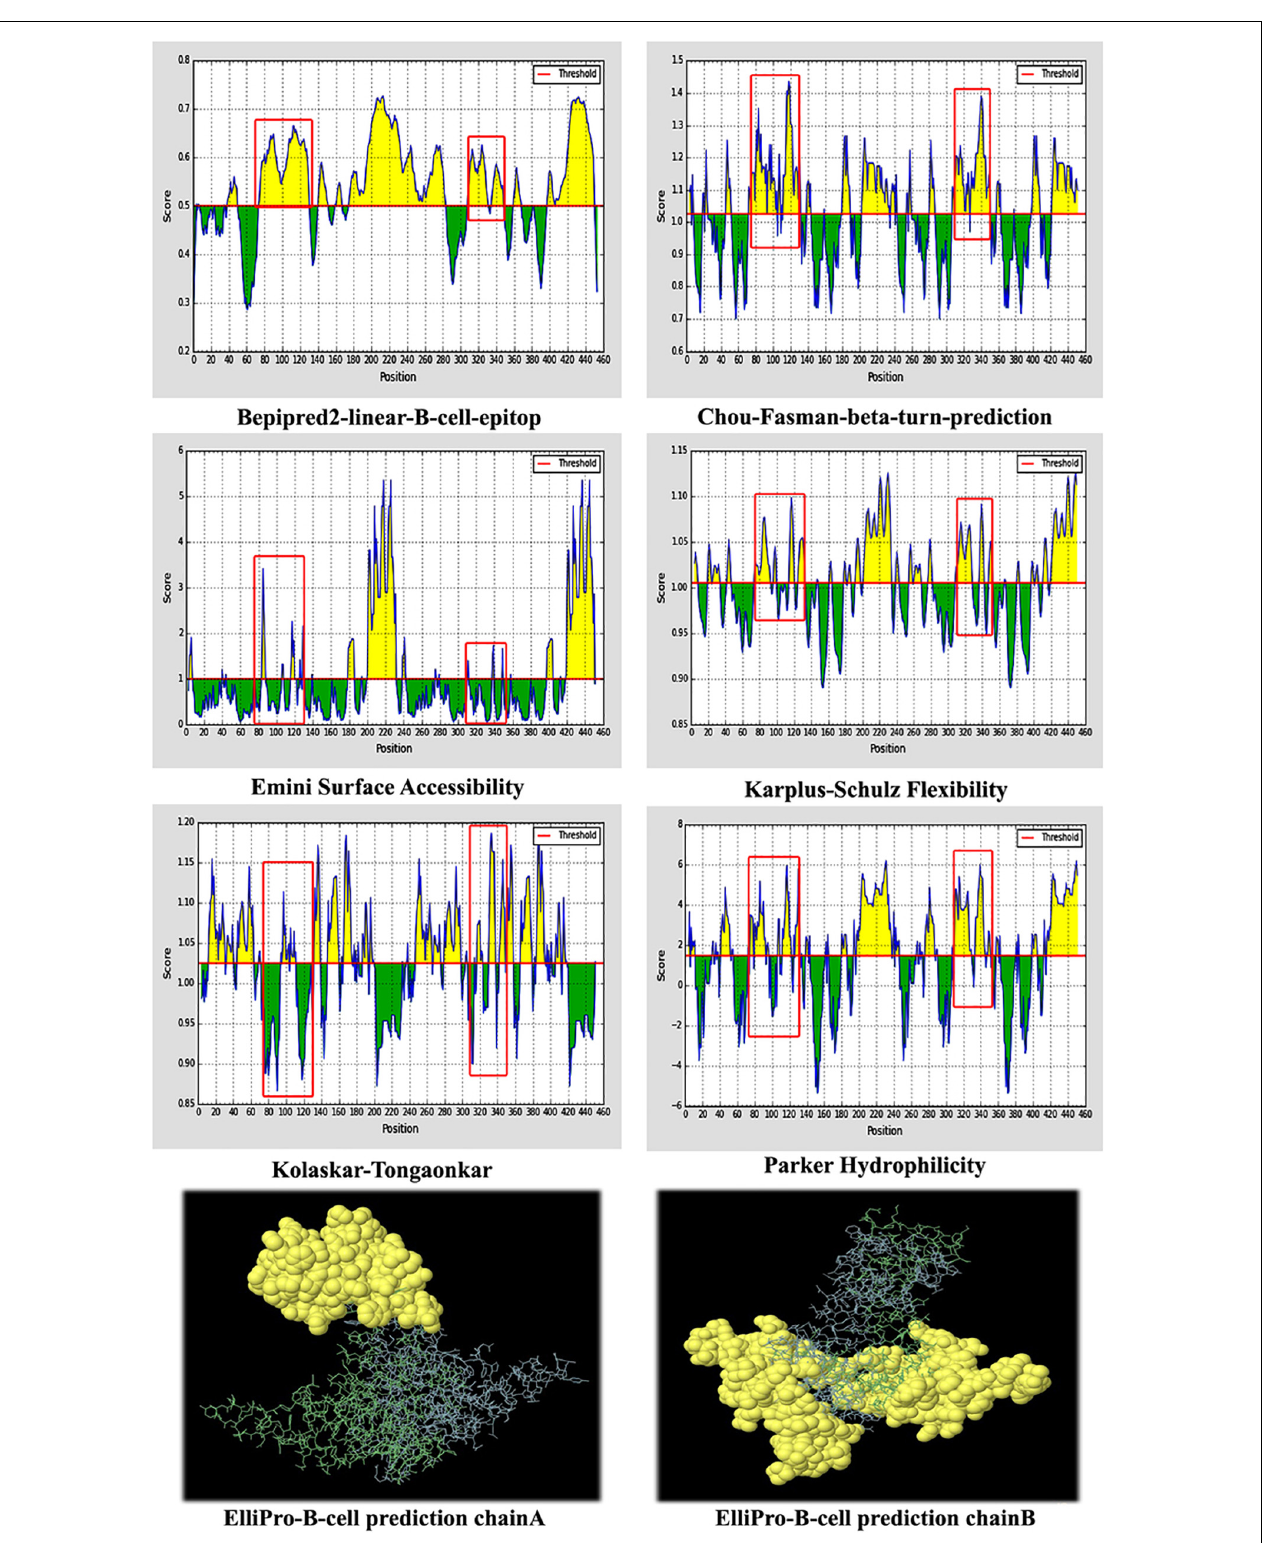
FIGURE 4 | Predicted B cell epitopes of the designed virus-like particle (VLP)-based vaccine. (A) Linear B cell epitopes based on the various physicochemical properties of the residues. The red boxes are related to the first and second fragments of hepatitis B surface antigen (HBsAg) inserted into hepatitis B core antigen (HBcAg). (B) Predicted discontinuous B cell epitopes for each monomer of the designed vaccine.